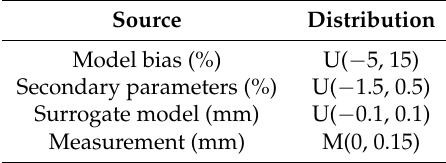
Table 7. Secondary (%) and surrogate modeling (mm) uncertainty at each sensor